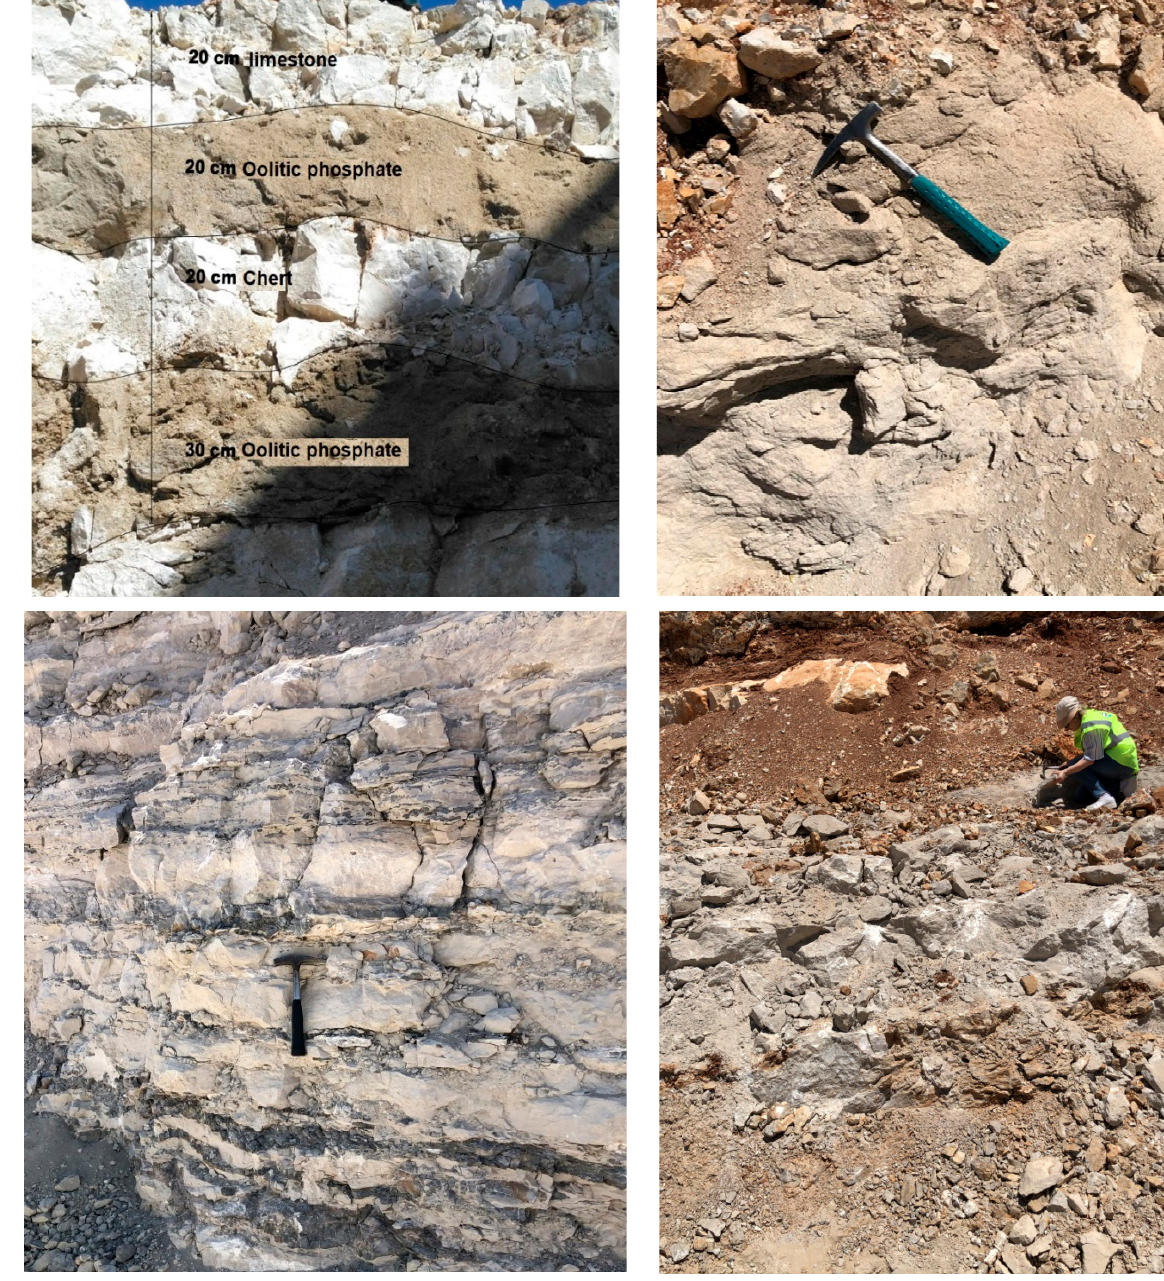
Figure 4. Typical phosphate and chert outcrops of the Maz ı da ğ ı